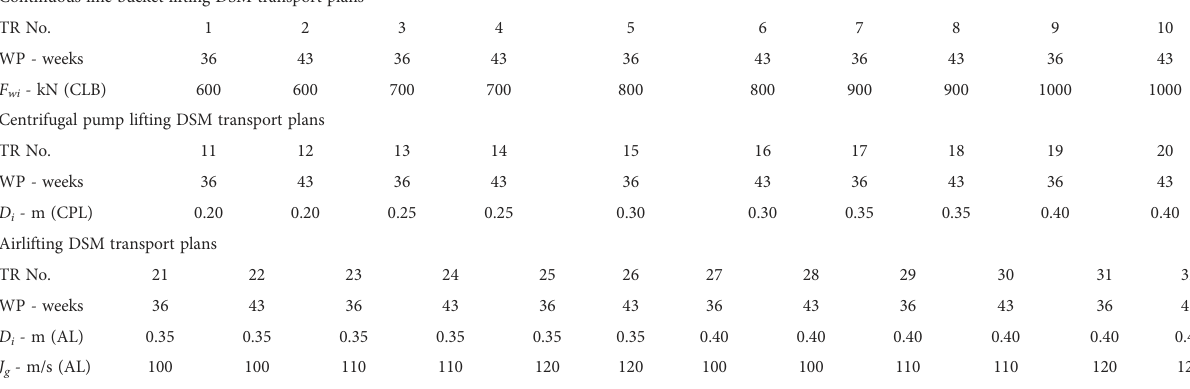
TABLE 4 Different kinds of DSM vertical transport plans. Continuous line bucket lifting DSM transport plans TR No.